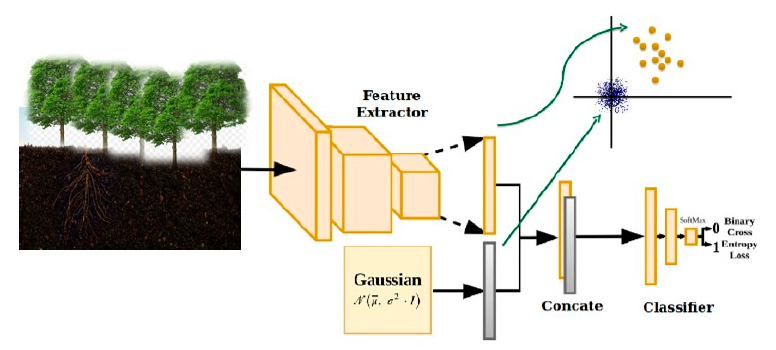
Figure 1. Gaussian probabilistic for the Soil Perception for adding nonlinearity.